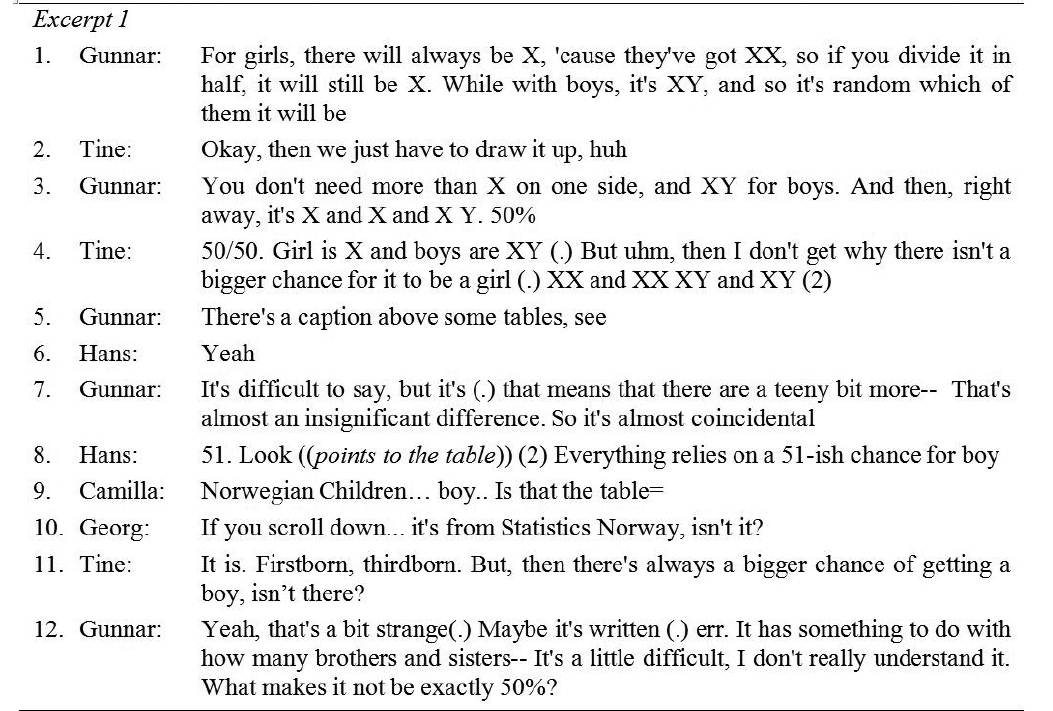
Figure 2. Pictures of the students working with the Punnett square diagram. Excerpt 1. Dealing with divergent